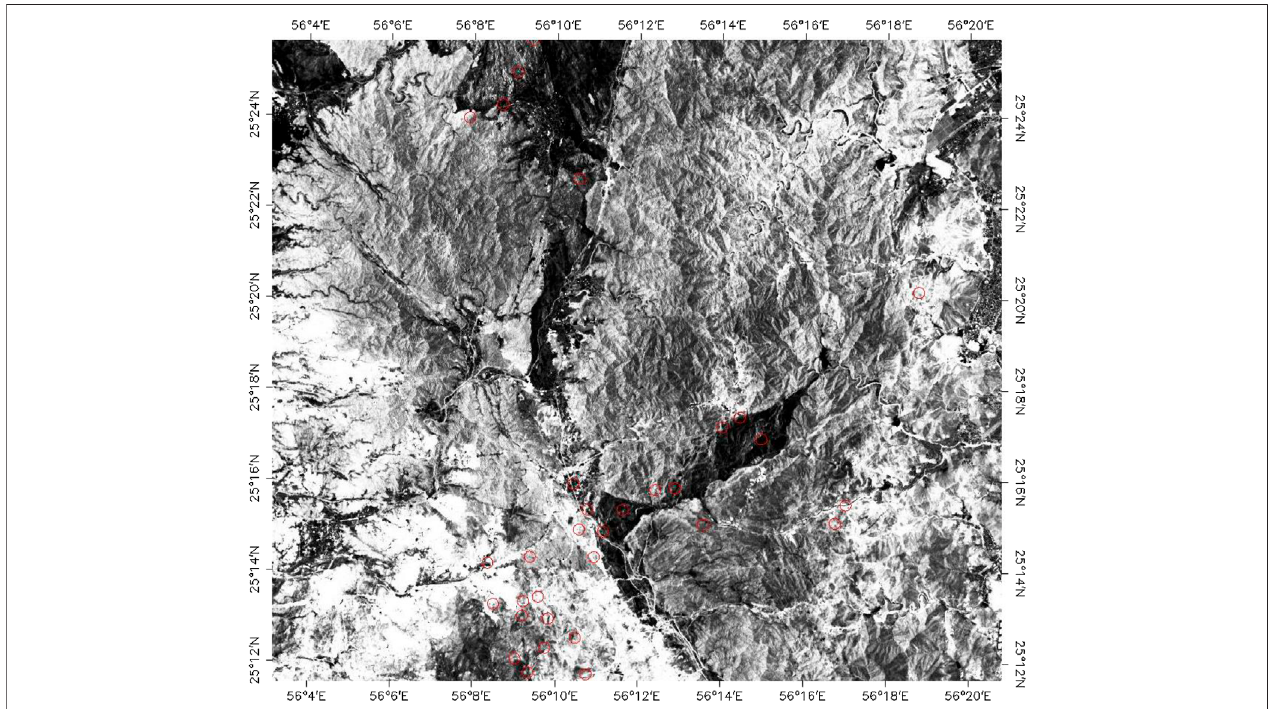
FIGURE15| ImageofMNF2forthestudyarea.Metamorphicsoleisshowninwhitepixels,whilegabbroandserpentinizedperidotiterocksexhibitdarkcolors.The locations of copper is shown in red circles.